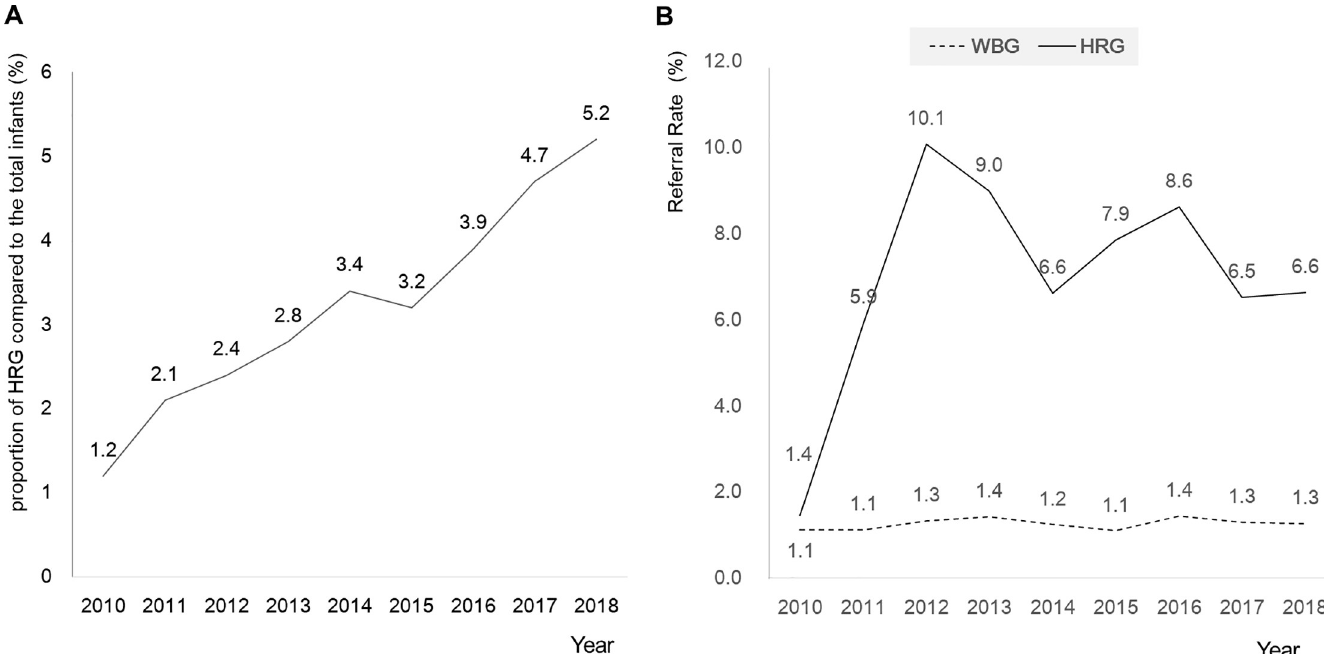
Fig 1. The annual proportion of the high-risk group (HRG) (A), and the annual referral rates of the well-baby group (WBG) and HRG (B) during 9 year-national pilot program. NHS: newborn hearing screening, well-baby group: newborns born healthy or stayed at the neonatal intensive care unit less than 5 days, High-risk group: infants who were hospitalized in the neonatal intensive care unit for more than 5 days.